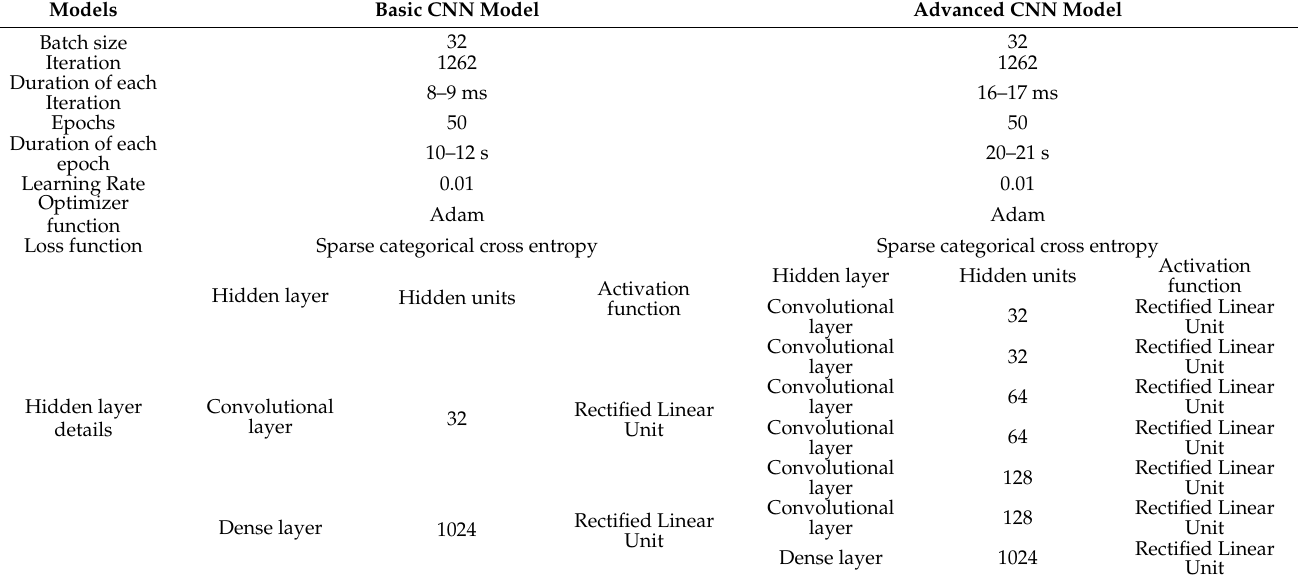
Table 2. Environmental specifications for the Basic and Advanced CNN